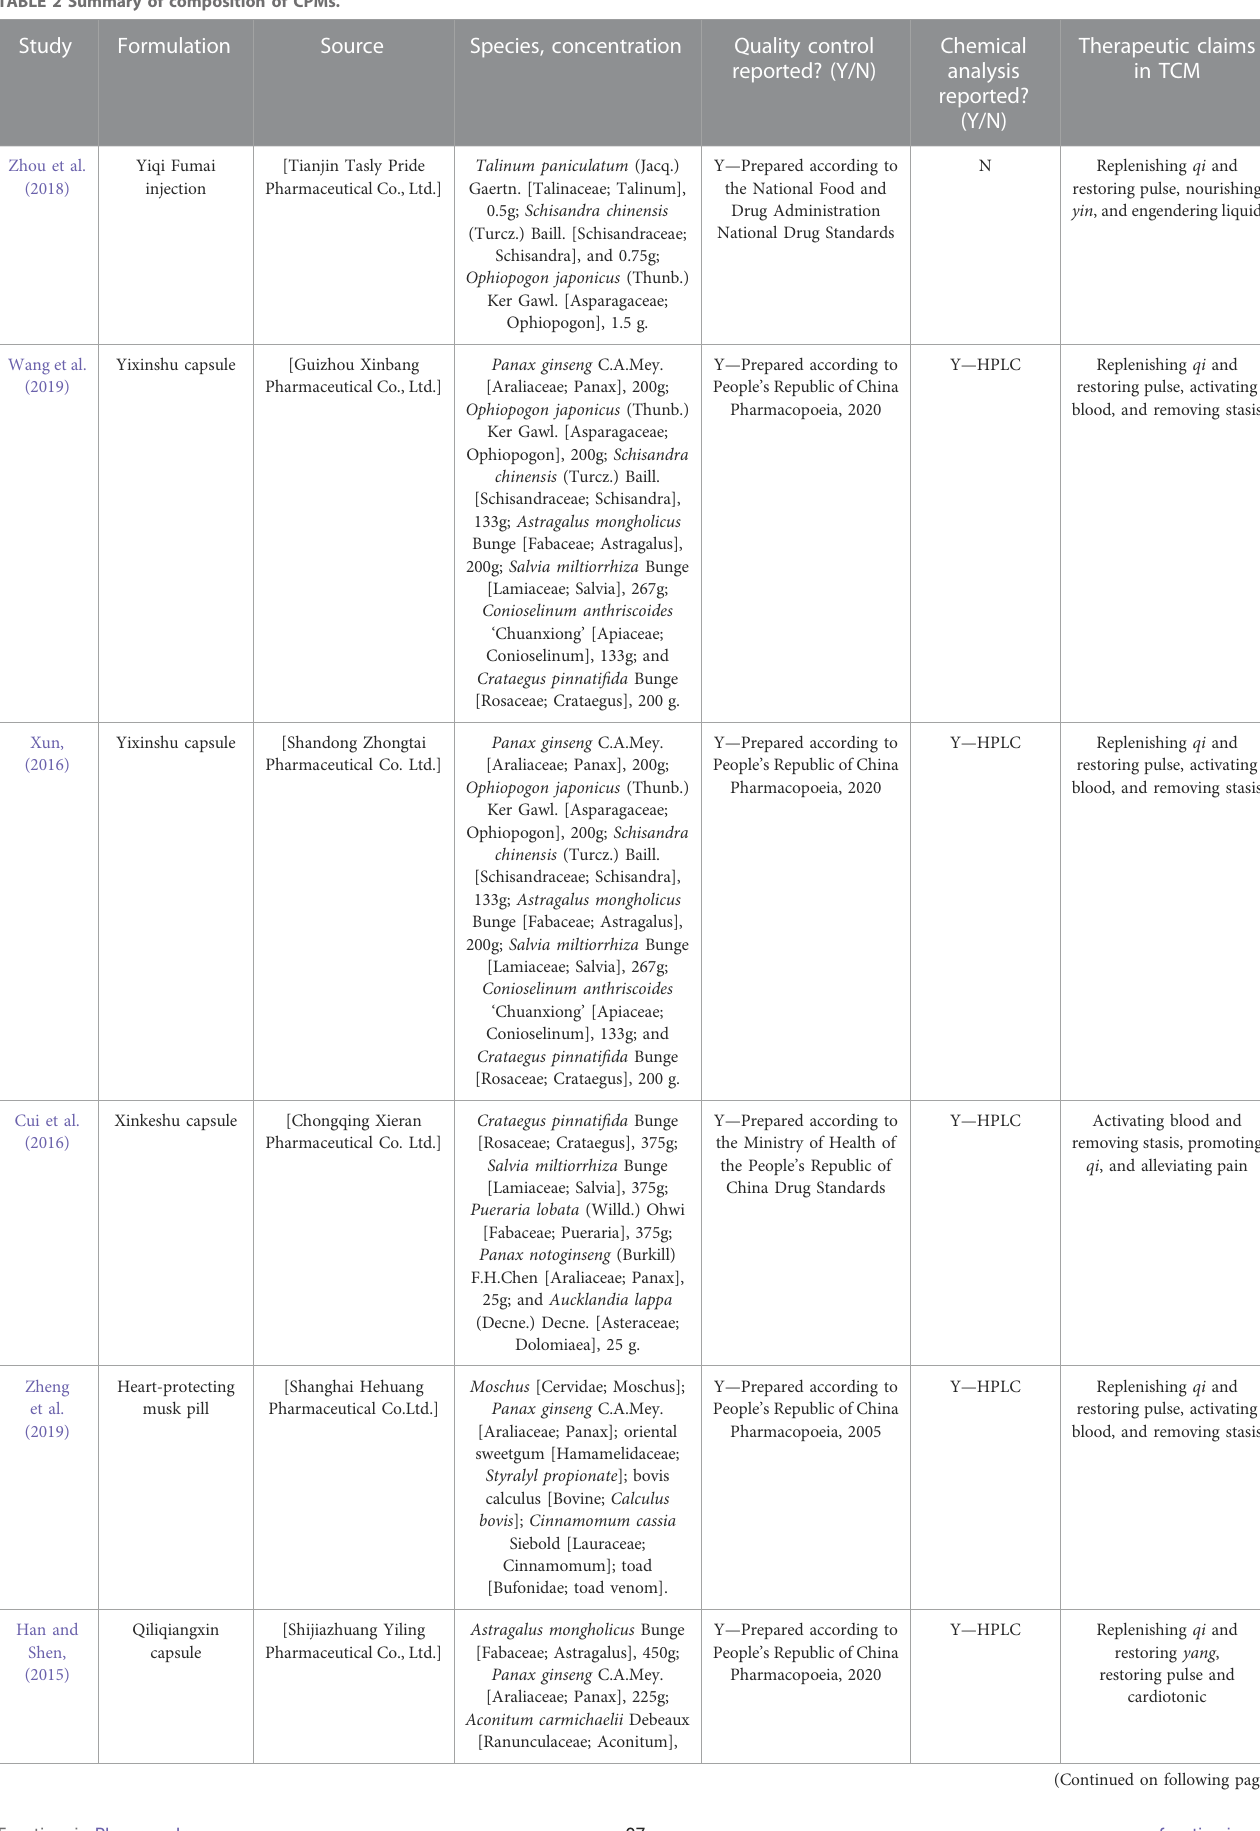
TABLE 2 Summary of composition of